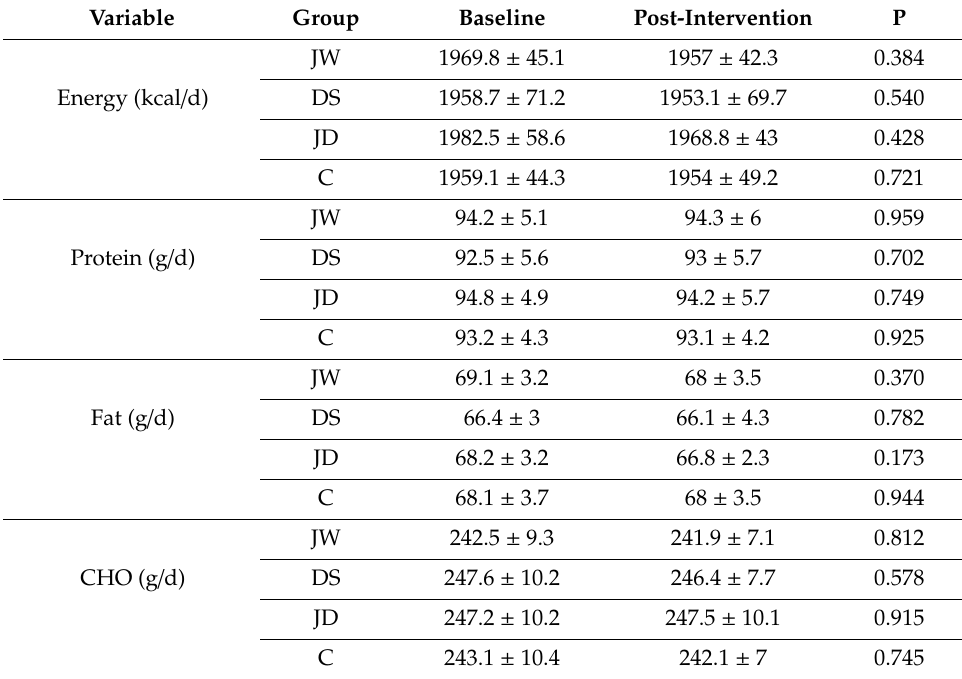
Table 3. Energy and macronutrients at baseline after 6